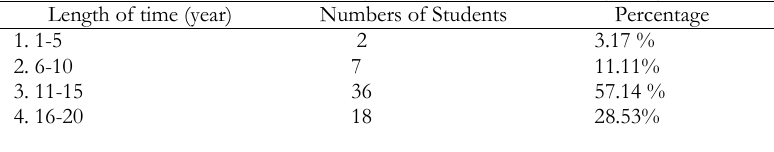
TABLE 2 . Length of time for studying